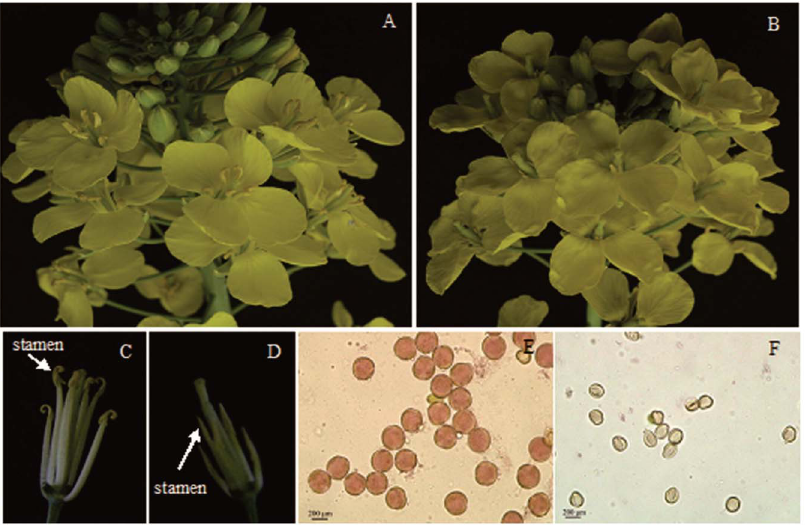
Figure 1. Flowers, stamens and pollens of control plants and MES-treated plants. A, C, E: control plant; B, D, F: MES-treated plants, Viable pollens were stained red by the acetocarmine method (E), but unviable pollens were not stained (F).